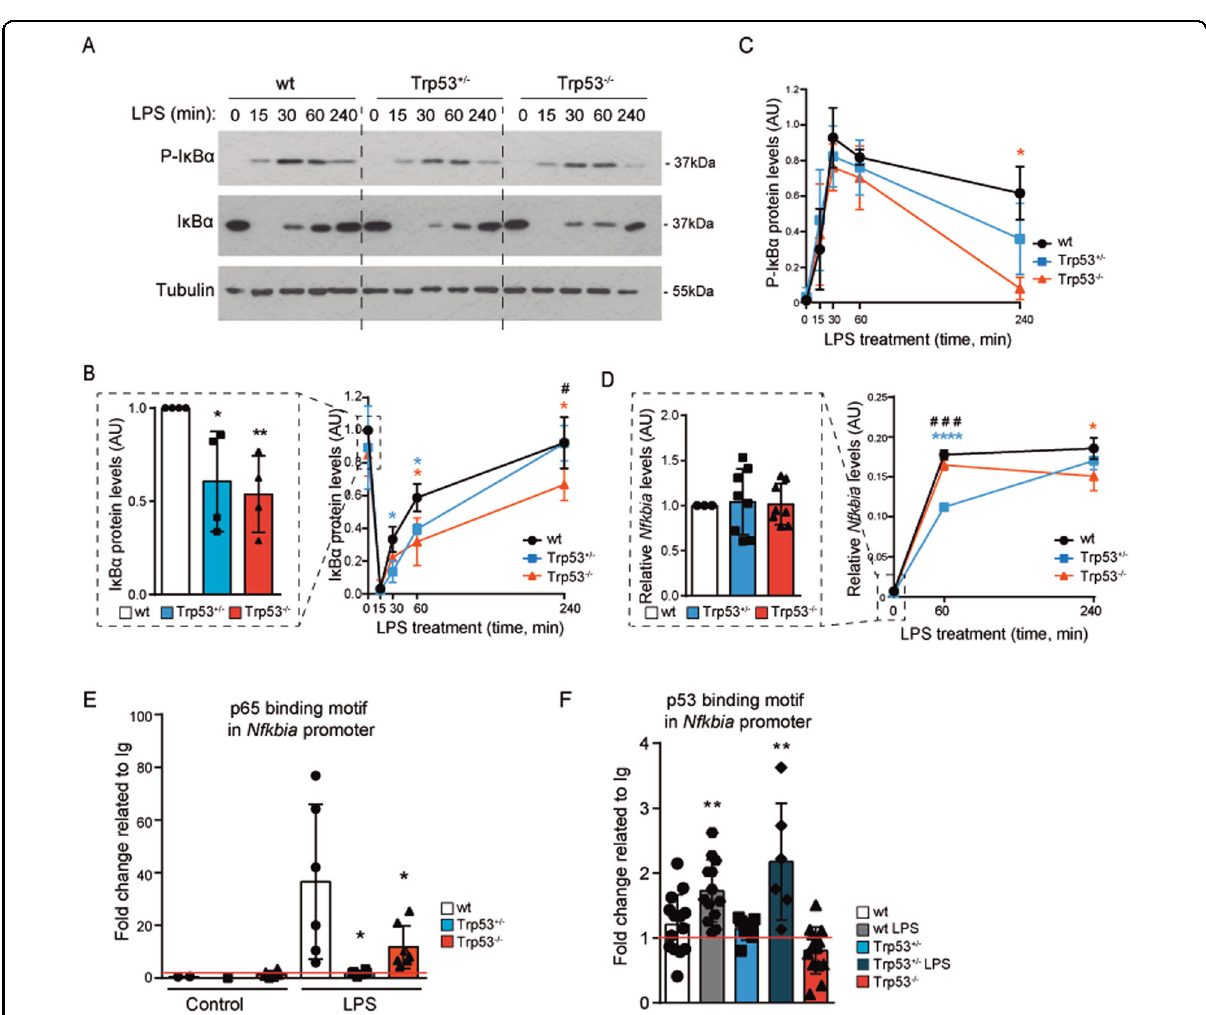
Fig. 5 Loss of one Trp53 allele affects NF- κ B pathway via regulation of I κ B α mRNA expression. A Levels of P-I κ B α and I κ B α in untreated and LPS-treated (100 ng/ml) BMDMs from p53 WT, HEM and KO mice at the indicated times. Representative image of a western blot analysis from three independent experiments is shown. B Quanti fi cation of I κ B α levels from three independent western blot analysis. A graph for basal levels (left panel) and a graph for LPS treatment (right panel) are shown. Expression values were referred to tubulin levels. C Quanti fi cation of P-I κ B α levels from